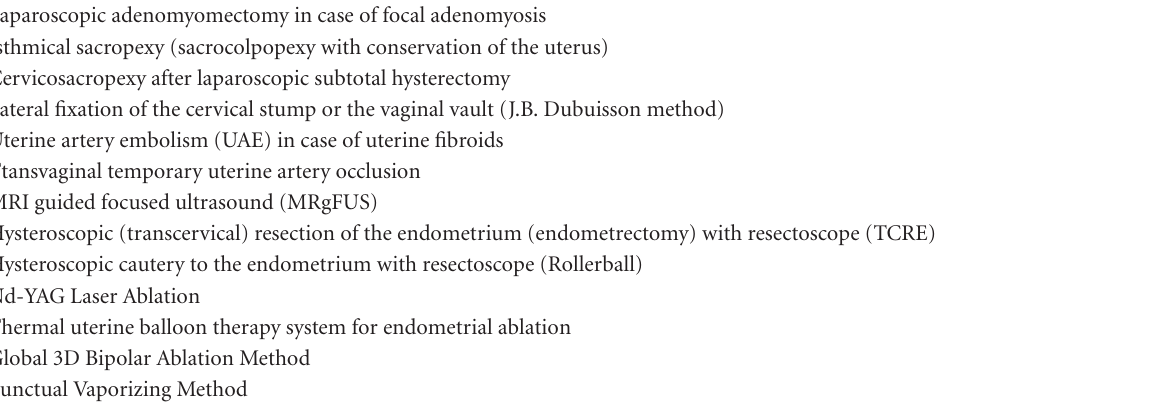
Table 1: Alternative to hysterectomy methods for benign disease. Laparoscopic adenomyomectomy in case of focal adenomyosis Isthmical sacropexy (sacrocolpopexy with conservation of the uterus) Cervicosacropexy after laparoscopic subtotal hysterectomy Lateral fixation of the cervical stump or the vaginal vault (J.B. Dubuisson method) Uterine artery embolism (UAE) in case of uterine fibroids Ttansvaginal temporary uterine artery